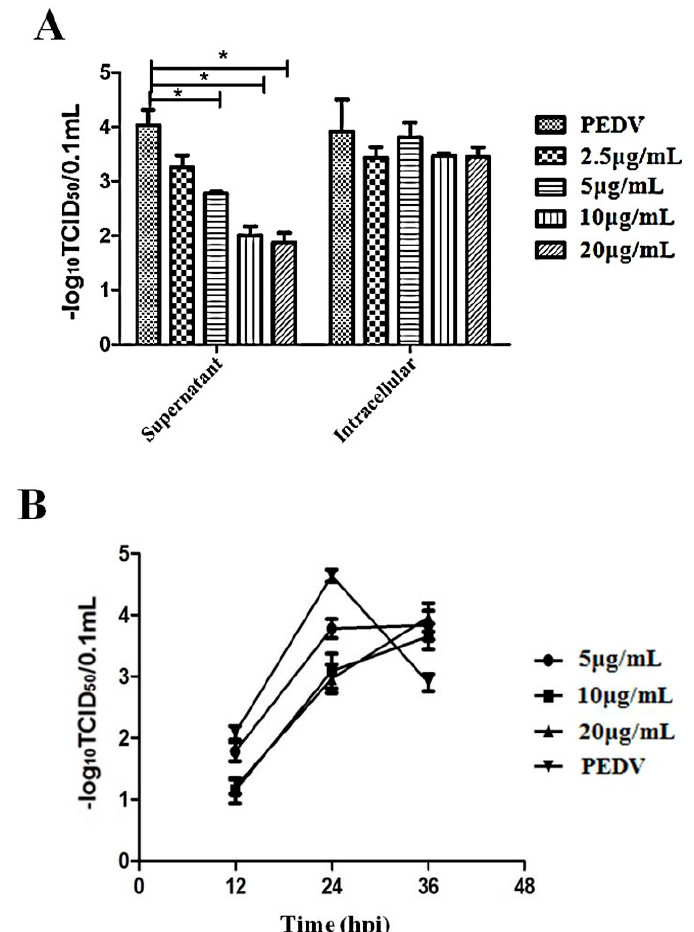
Figure 5. The inhibitory effect of Caerin1.1 against the progeny virus production of porcine epidemic diarrhea virus (PEDV). ( A ) The intracellular and extracellular progeny virus titers were detected after treatment with different concentration of Caerin1.1. The concentration of Caerin1.1 used in the experiments are 2.5, 5, 10, 20 µ g/mL, respectively; ( B ) The progeny virus (extracellular virus) titers were also detected under treatment with different concentration of Caerin1.1 (5, 10, 20 µ g/mL) at different time points (12, 24, 36 h). The results of three independent experiments are presented as the mean ± SD. The statistical analysis was performed using Graph Pad Prism5.0. The significance was defined as p < 0.05 (*).